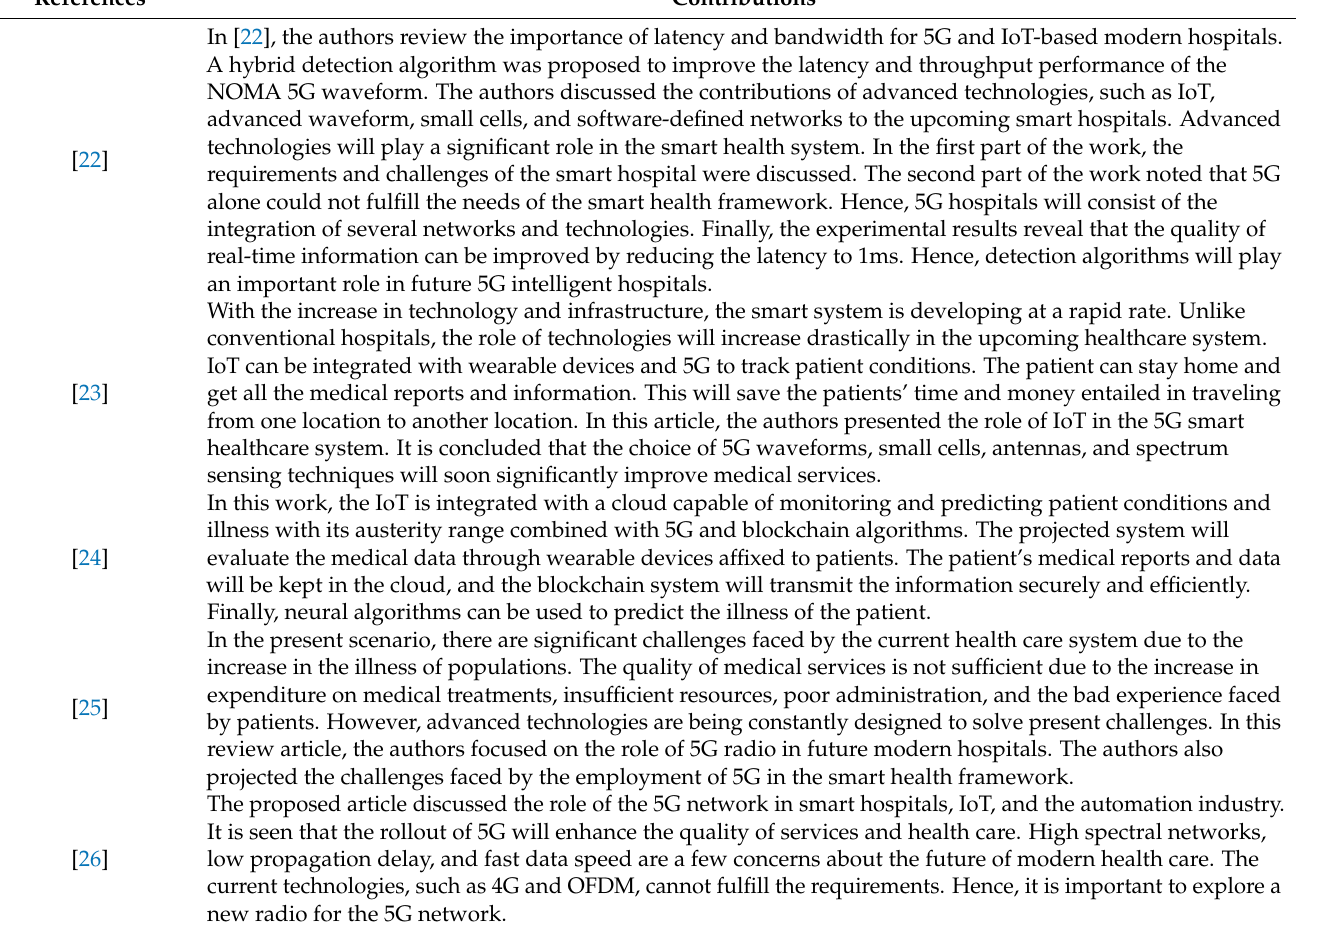
Table 1. Related